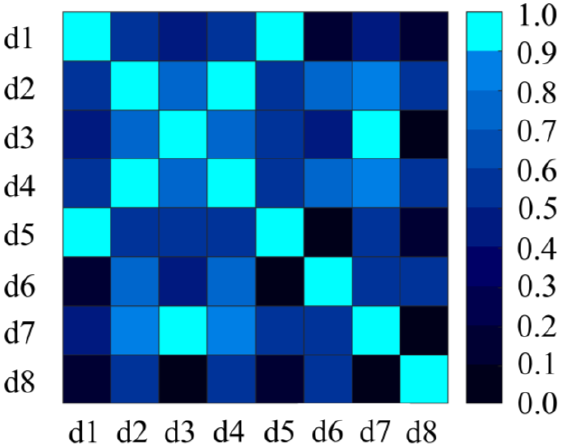
Figure 6. The absolute value of the Spearman correlation between the extracted features from the simulated DP SAR data.